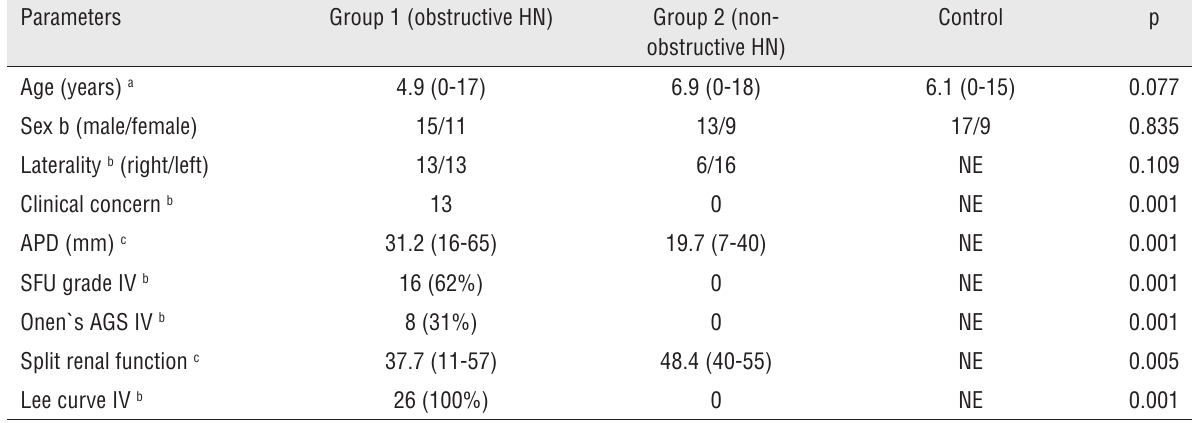
Table 1 - Demographic and clinical characteristics parameters of the patient and control groups showed as average, minimum and